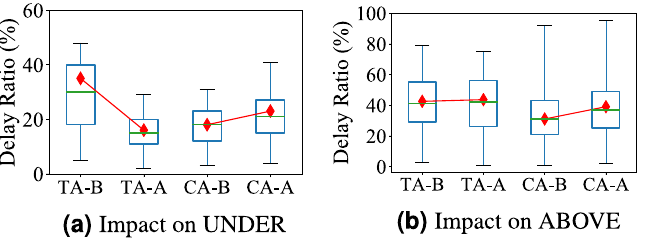
Figure 6. Impact of new stations; ( a ) it decreases the travel delay in the underground system; ( b ) it decreases the travel delay in the aboveground system.